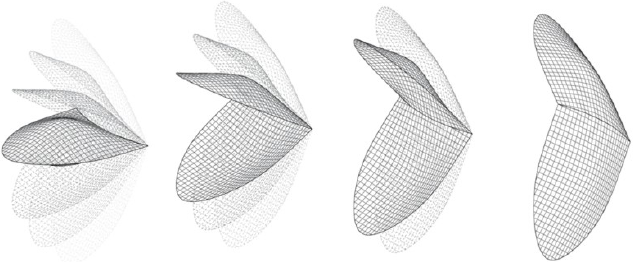
Figure 9. Through the controlled bending of the connecting beam element, the attached flexible shells demonstrate a large complex